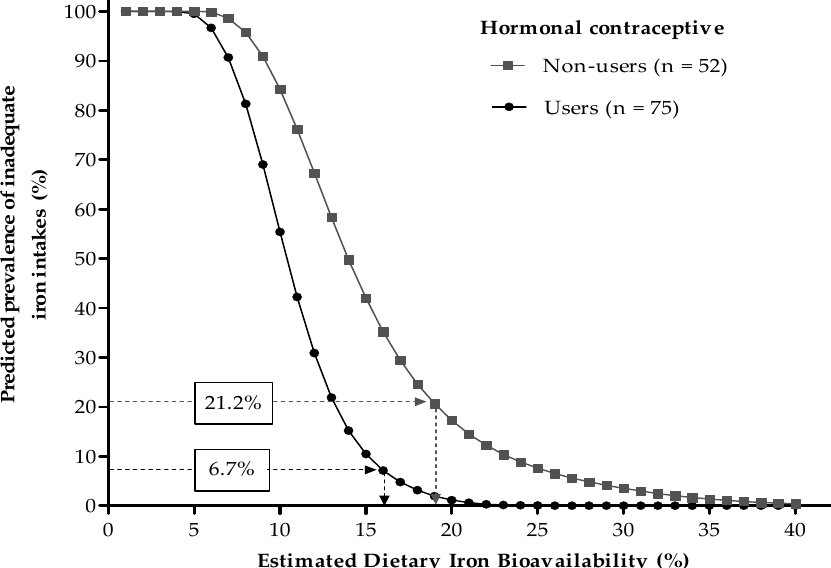
Figure 2. Predicted prevalence of inadequate iron intakes at different dietary iron bioavailabilities, according to the probabilistic approach proposed by Dainty et al. [14]. Values in boxes are prevalence of iron deficiency (serum ferritin < 15 µg/L). Mean dietary iron bioavailabilities of 16% and 19% were estimated for hormonal contraceptive users and non-users, respectively.